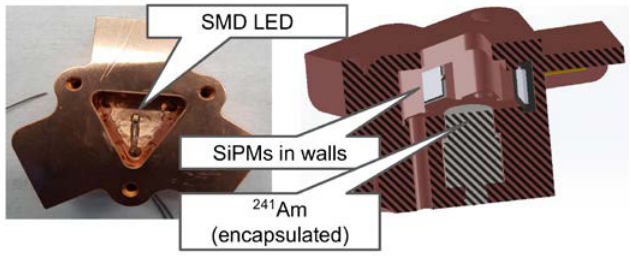
Fig. 7. Photo of the light source (left) and cut view rendering (right). The bottom of the triangular cavity houses both an encapsulated 241 Am source and a SMD LED for production of VUV and green photons, respectively. Three SiPMs in the walls yield trigger